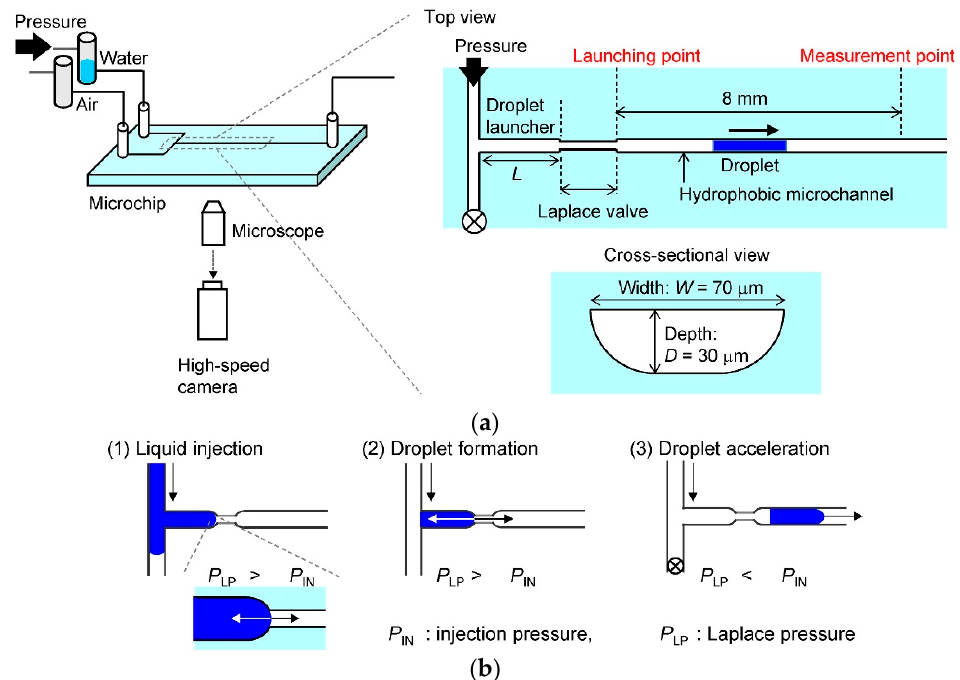
Figure 1. Schematics of ( a ) experimental setup for acceleration of a microdroplet in gas phase in a microchannel and ( b ) microfluidic process for droplet formation and acceleration. The microfluidic device consists of a droplet launcher, a Laplace valve and an acceleration microchannel. The channel wall is modified hydrophobically. During the process, (1) liquid is injected into the droplet launcher, (2) a droplet is formed by air flow, and (3) the droplet is accelerated in the microchannel.